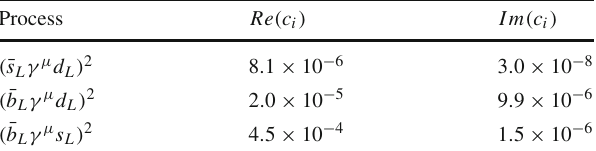
Table 1 Upper bounds on the Wilson coefficients of operators con- tributing to (cid:8) F = 2 processes corresponding to M KK = 3 TeV Process